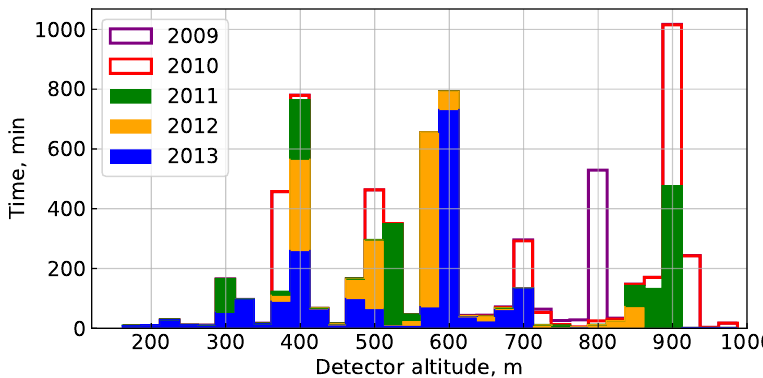
Figure 16. Altitude distribution over the experiment